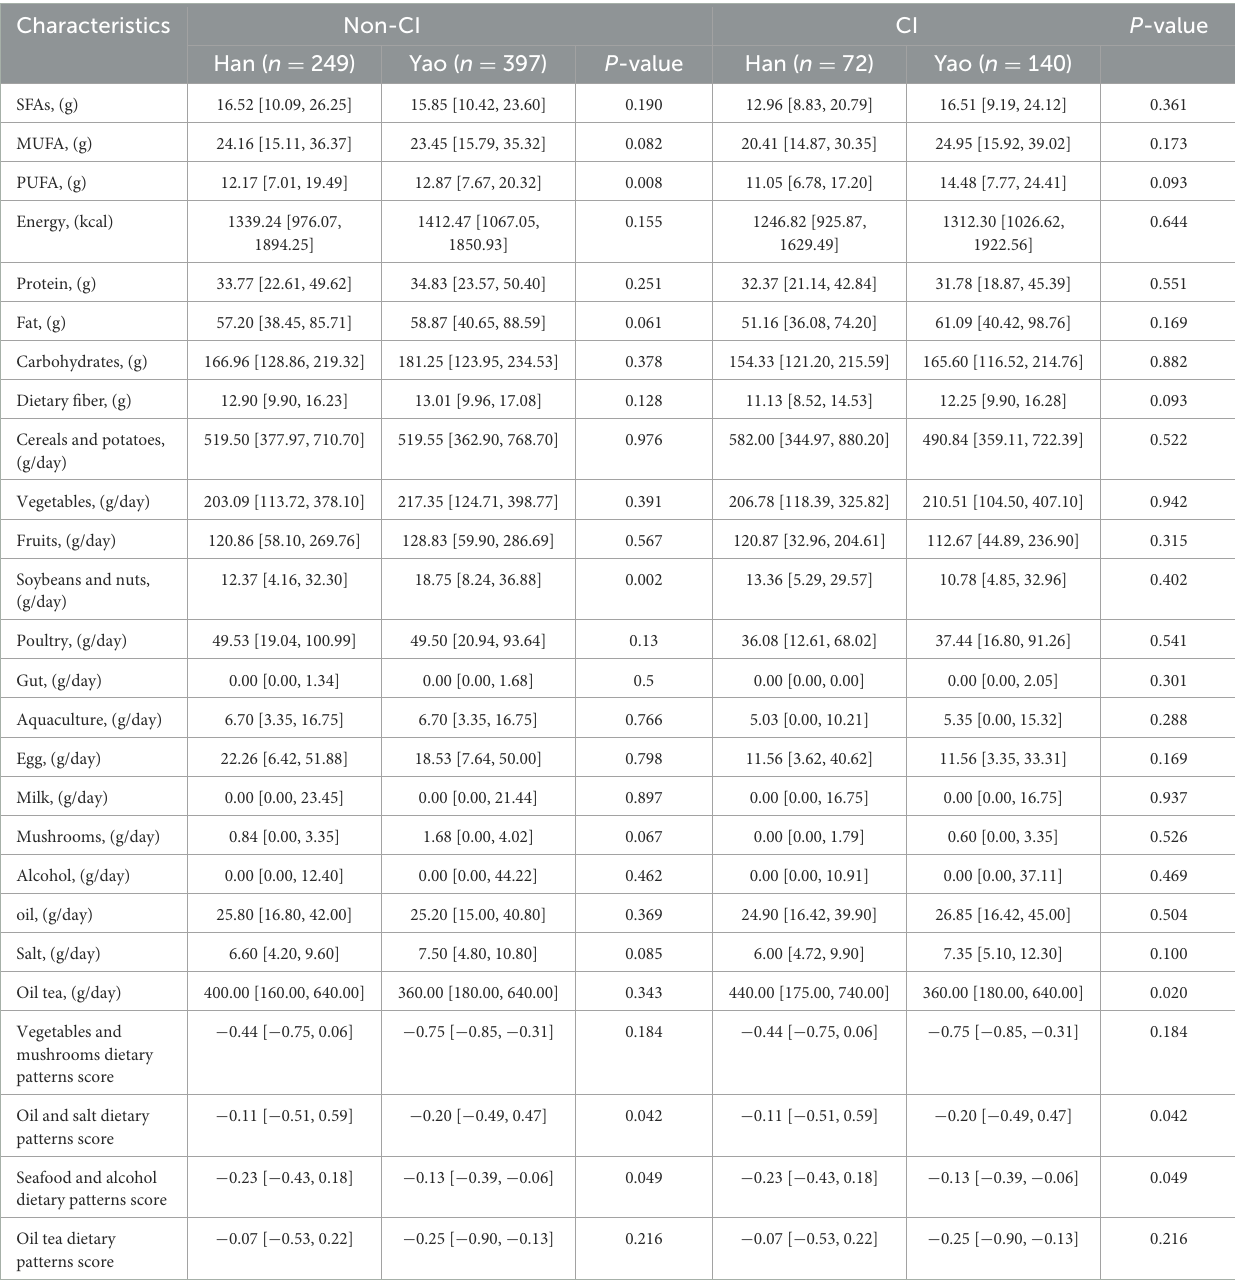
TABLE 4 Nutrients in the cognitively impaired and normal group, and factor scores by ethnicity.